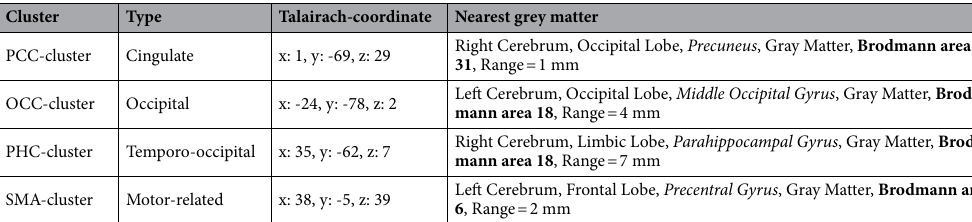
the SMA-cluster did not reach significance for the door widths ( F 2,26 = 0.36, p = 0.701, µ 2 = 0.027 ) nor interactions ( F 14,273 = 0.517, p = 0.923, µ 2 = 0.026 ). However, the OCC-cluster revealed significant main effects for door widths ( F 2,30 = 7.202, p = 0.002, µ 2 = 0.324 ) without significant interactions ( F 14,315 = 0.349, p = 0.987, µ 2 = 0.015 ). Equally, the PHC-cluster reached significance for door widths ( F 2,30 = 3.441, p = 0.045, µ 2 = 0.187 ), also without reach- ing significance for the interaction term ( F 14,315 = 0.409, p = 0.972, µ 2 = 0.018 ). The posthoc Tukey HSD analyses confirmed that the PHC-cluster and OCC-cluster reflected the affordances of the environment (all p-values are Bonferroni-corrected and reported in Fig. 6). These results suggest that during the immobile phase of the experi- ment, the PHC-cluster and the OCC-cluster reflected the architectural affordances via alpha ERD (see ‘Supple- mentary material 1 ′ for all ERSPs within this immobile phase). Mobile phase ERSPs. Similar for the mobile phase, permutation tests first indicated significant differ- ences across door widths. Two-way 3 × 8 ANOVA repeated measures for each cluster were computed. Dur-